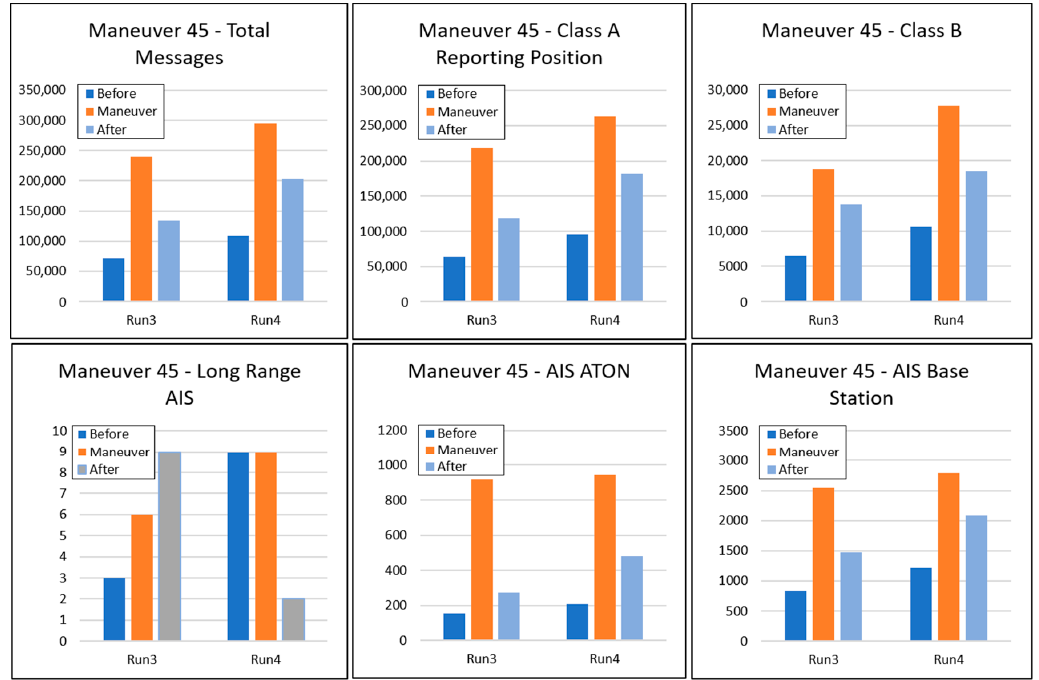
Figure 10. Comparison of AIS message acquired under the 45°-maneuvered flight configuration.